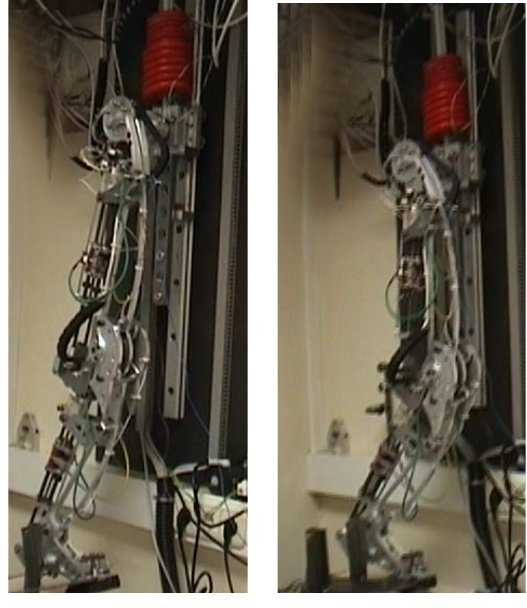
Figure 27. Experimental cycles of knee flexion-extension with a 13-kg payload over the